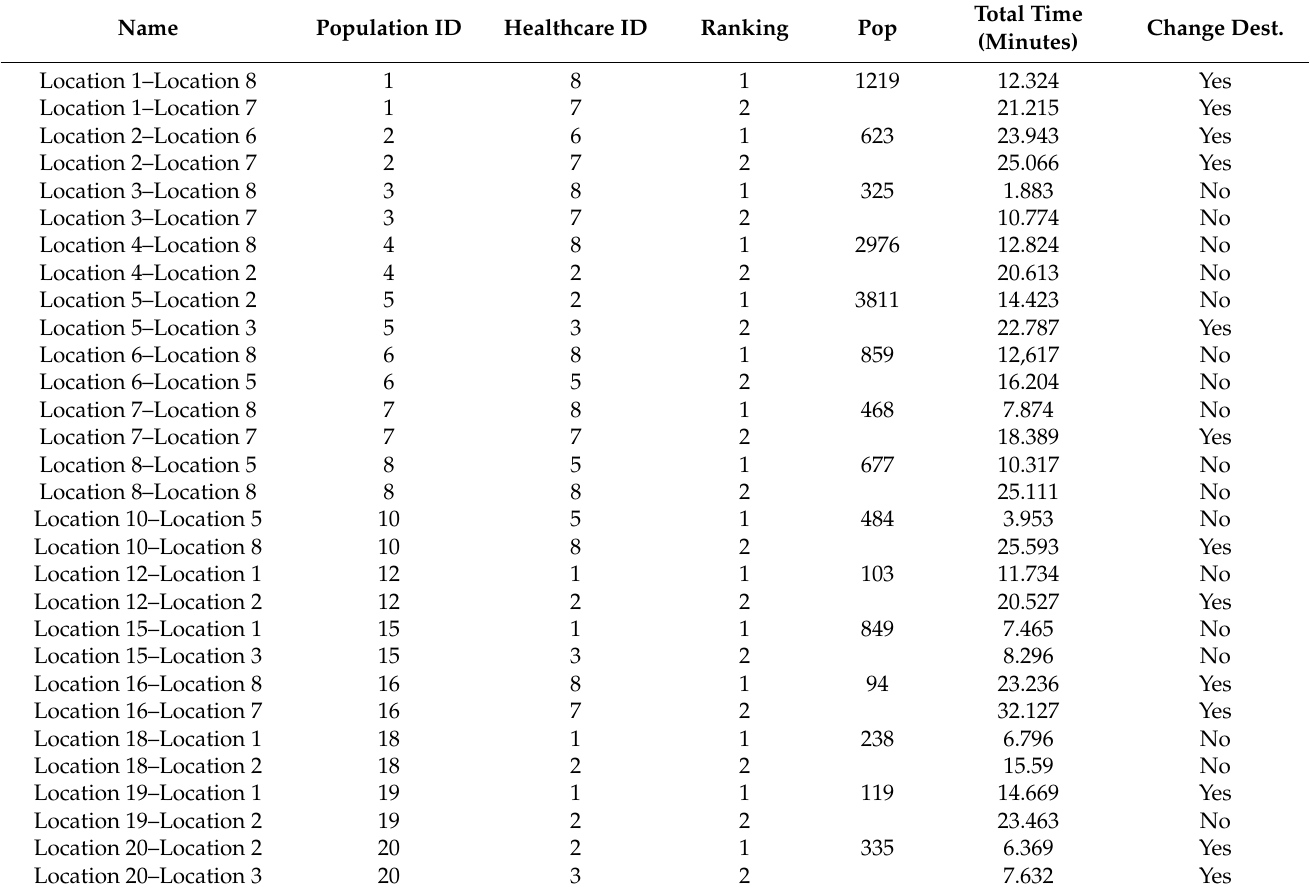
Table 7. Evacuation route time, population (Pop), and healthcare capacity after